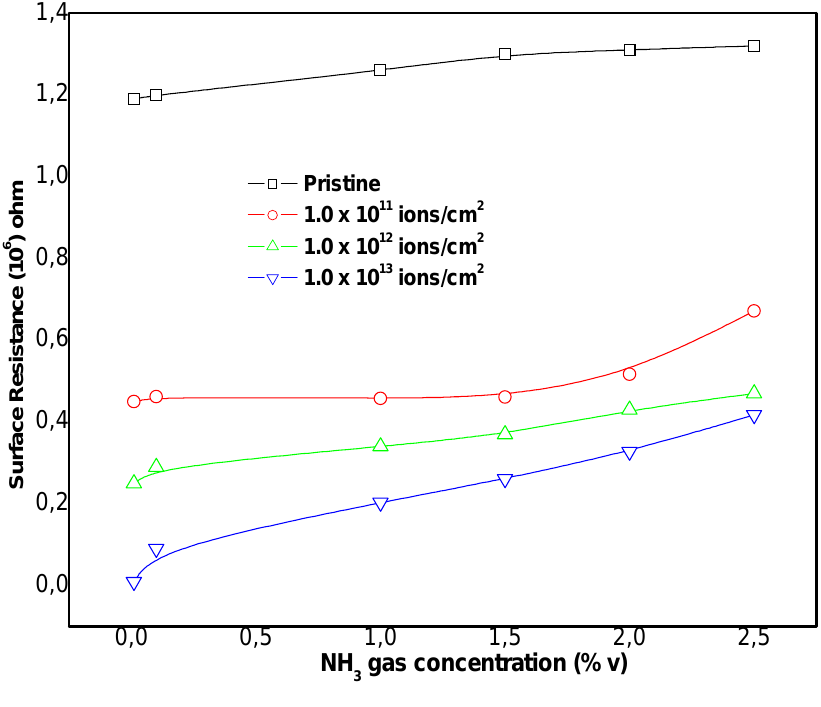
Figure 3. Plot of surface resistance as a function of ammonia gas concentration at different ion